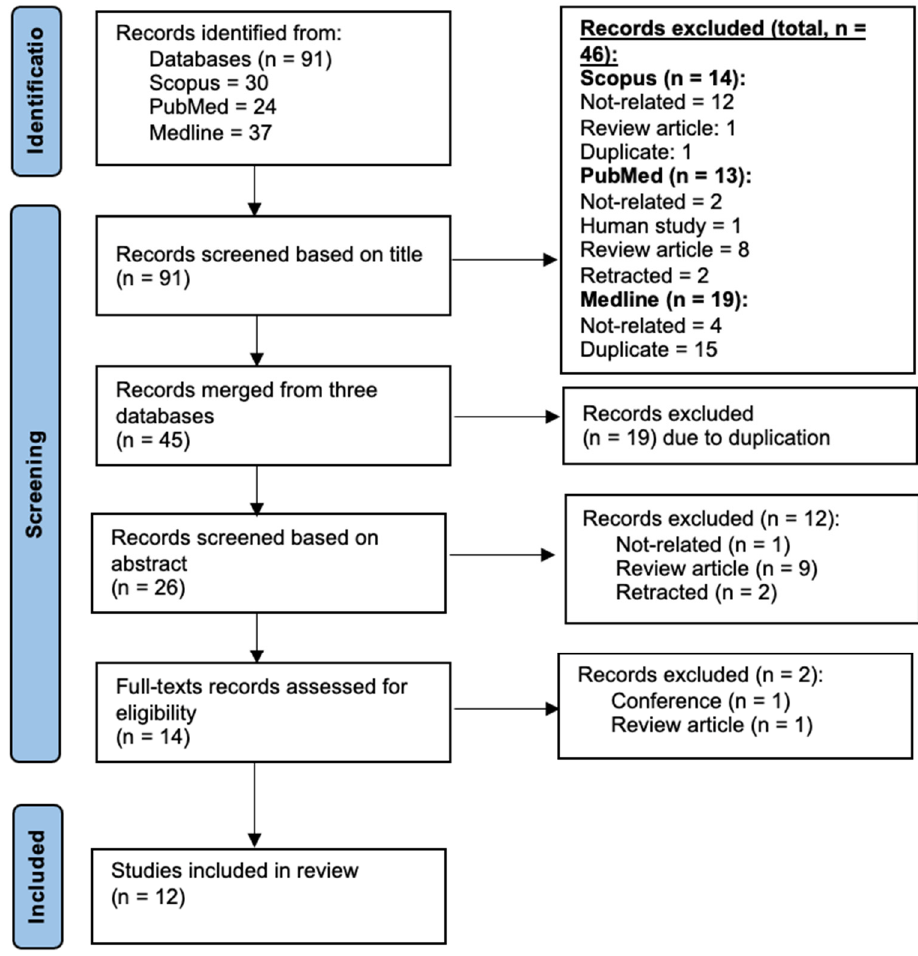
Figure 2. PRISMA flow diagram for the identification of studies via databases.